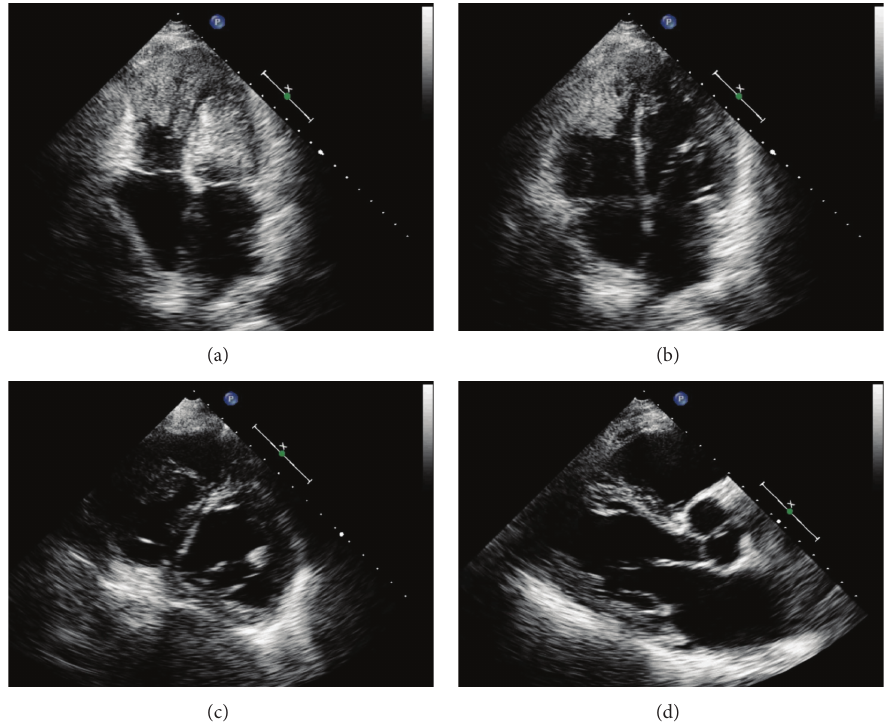
Figure 3: Transthoracic echocardiogram showing irregular mass in the right ventricle.